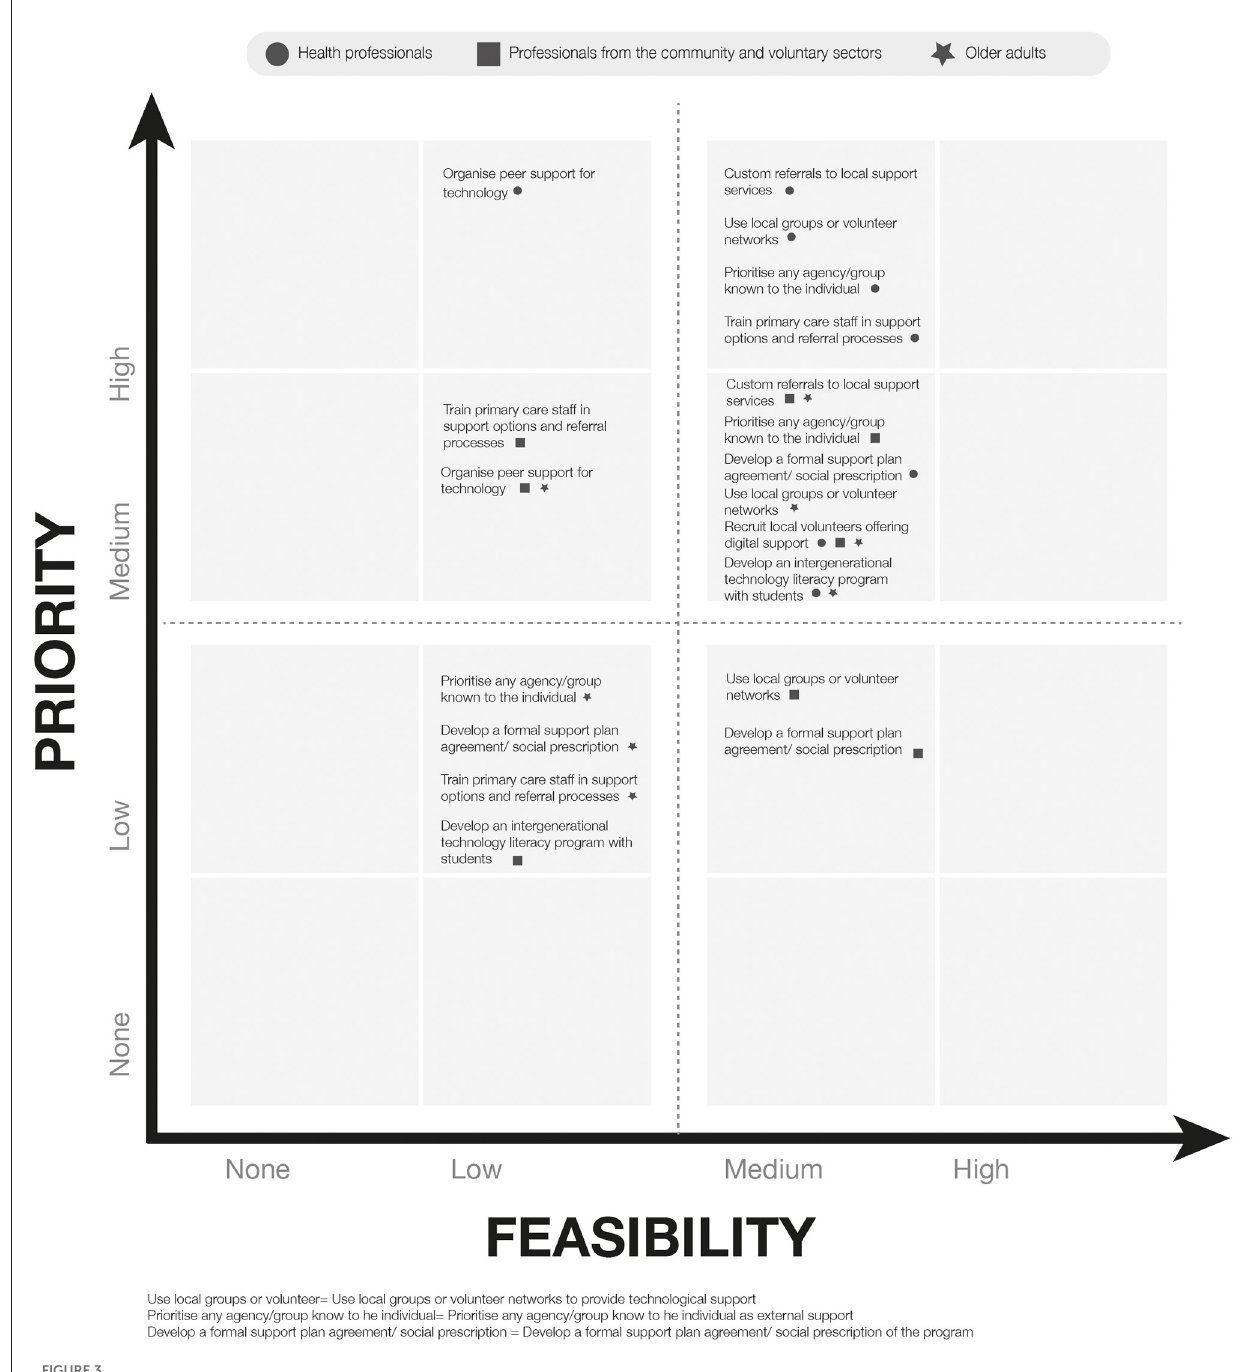
FIGURE3 Mapping of responses to specific strategies to facilitate external support.